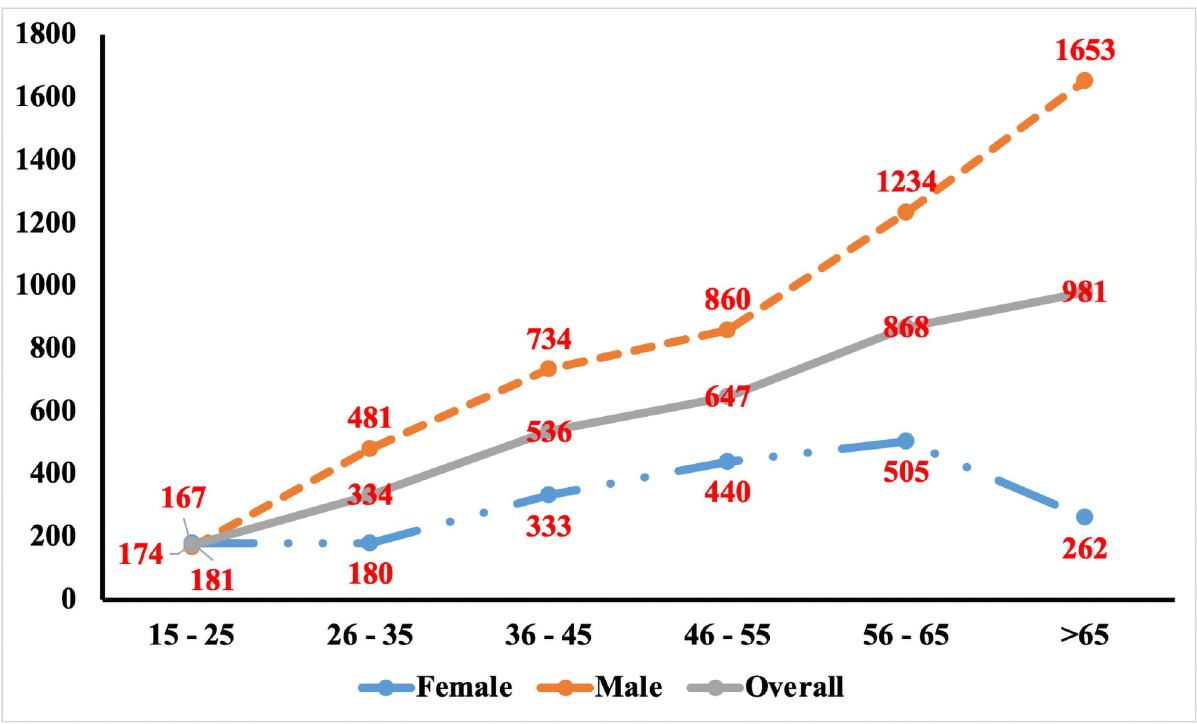
Fig 2. Age and gender wise prevalence of bacteriologically positive pulmonary TB based on MI corrected for Xray screening.